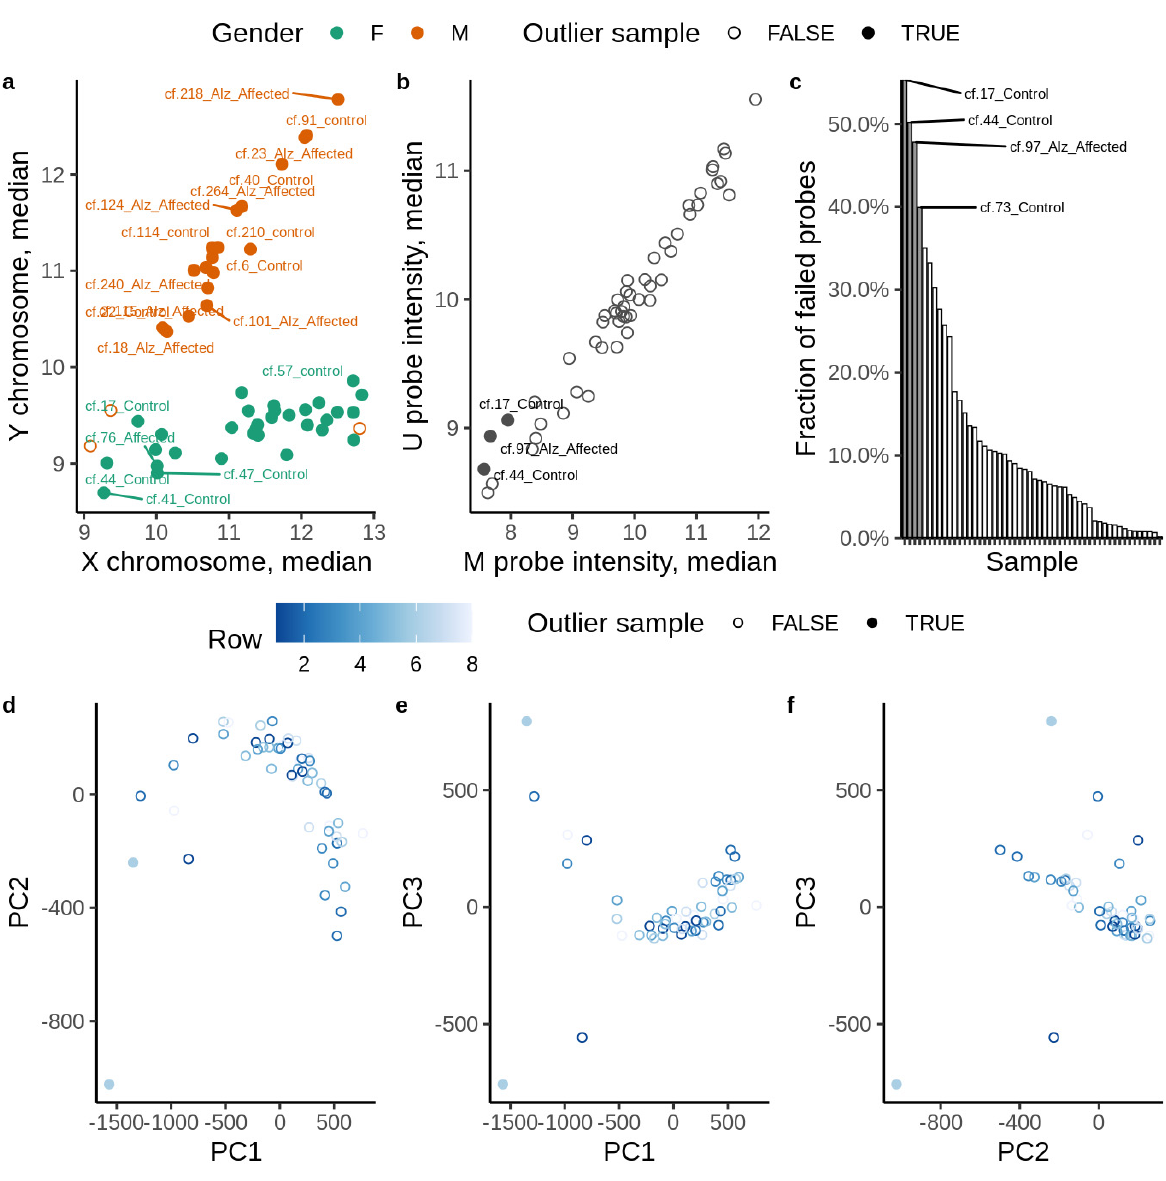
Figure 1. Detection of outliers in EPIC array methylation data. ( a ) Median signal intensity in sex chromosomes. ( b ) Median overall probe intensity. ( c ) Fraction of failed probes. Samples that deviate by more than 2 SD from the average fraction of failed probes are considered outliers. ( d – f ) Principal component